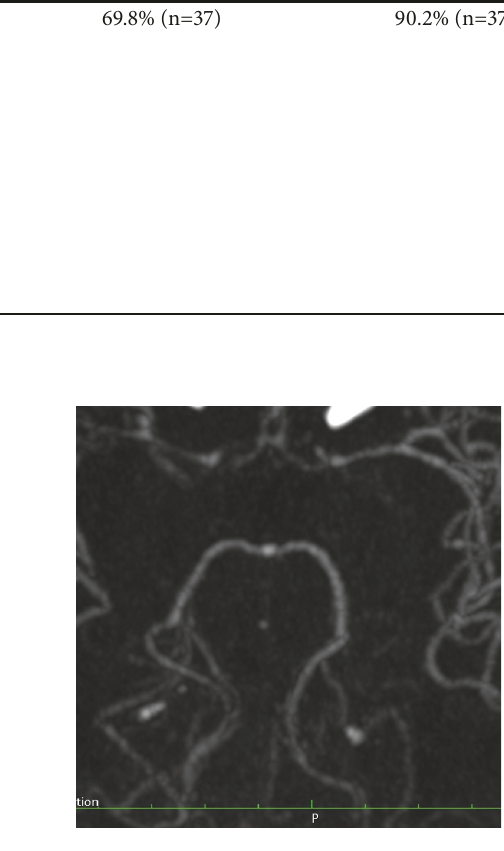
Figure 3: Axial MIP image showing combined type A anterior circulation variant and type E posterior circulation